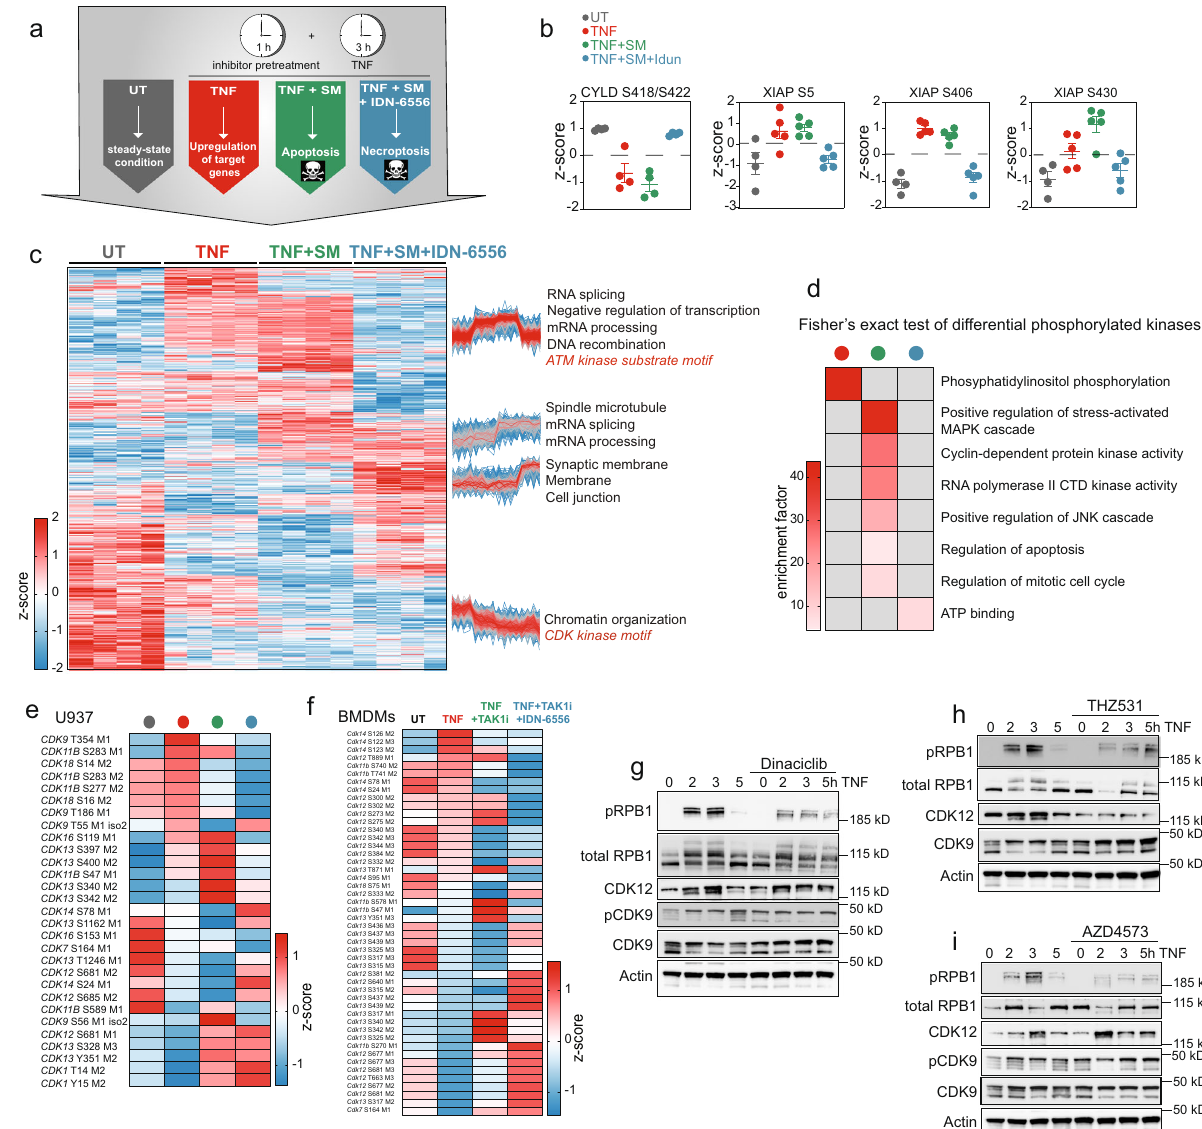
Fig. 4 TNF-induced cell death leads to a strong RNA-processing response and regulation of the phosphorylation status of CDKs. a Experimental scheme of U937 cells that were untreated, treated with TNF (100 ng/ml, red) alone, treated with TNF and Smac mimetic (SM/Birinapant, 1.25 μ M, green) to induce apoptosis, or with TNF, SM, and IDN-6556 (Emricasan, 10 μ M, blue) to induce necroptosis. b Z-scored phosphosite intensities of CYLD and XIAP that are regulated upon TNF treatment, TNF-induced apoptosis, and TNF-induced necroptosis (±SEM, n = 4 biologically independent experiments). XIAP phosphosites were retrieved from a DDA dataset (Methods). c Heatmap of z-scored phosphosite intensities that are one-way ANOVA signi fi cantly regulated upon TNF treatment or TNF-induced cell death (FDR < 0.05). The pro fi les are color-coded according to their distance from the respective cluster center (red is close to the center, blue is further away from the center). d Fisher ’ s exact test on kinases with signi fi cantly regulated phosphosites upon different treatments (FDR < 0.02). e Heatmap of means of z-scored phosphosite intensities of CDKs that signi fi cantly changed upon treatment of U937 cells (one-way ANOVA, FDR < 0.05). f Heatmap of means of z-scored phosphosite intensities of CDKs that changed signi fi cantly (one-way ANOVA) upon treatment of BMDMs with TNF (red) alone, TNF, and TAK1 inhibitor (TAKi, 1 μ M) to induce apoptosis (green) or TNF, TAK1i, and the caspase inhibitor IDN-6556 to induce necroptosis (blue). Untreated cells (UT) served as controls (FDR < 0.05). g – i Immunoblots of U937 cells stimulated with TNF as indicated or in combination with CDK inhibitors Dinaciclib (6 nM) ( g ), THZ531 (200 nM) ( h ), and AZD4573 (6 nM) ( i ) and probed with antibodies against phosphorylated (S2) and total (N-terminal) RPB1, phosphorylated (T186), and total CDK9, CDK12, and β -actin ( n = 2 biologically independent experiments). Source data are provided as source fi necroptotic mediators MLKL and RIPK3 failed to die (Fig. 6a – d, h; TNF (Fig. 6a – d; Supplementary Fig. 6b). Supplementary Fig. 6c, f, g). The difference in necroptosis exacerbation between the different CDK inhibitors suggests a different mode of action of CDK12/13 inhibitors and other inhibitors for transcriptional CDKs. Whether this is based on their differential impact on FLIP isoform expression, remains to be determined. Synergistic induction of apoptosis is not restricted to